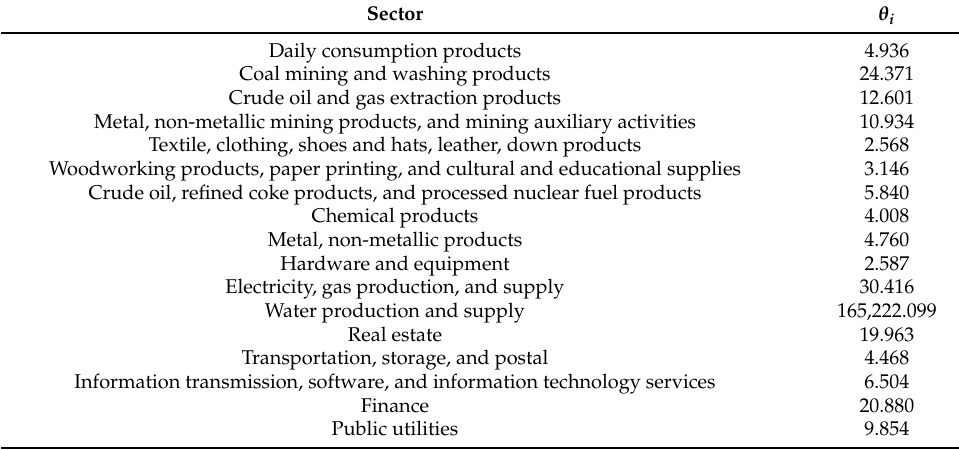
Table A8. The results of calibration of θ i